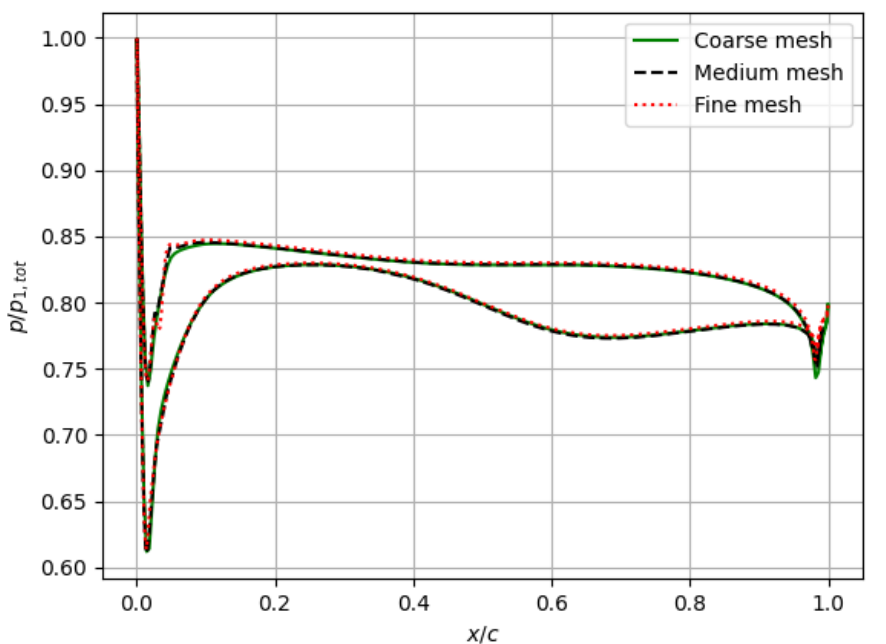
Figure 4. Distribution of the pressure along the middle blade calculated with coarse, medium, and fine mesh ( α = 3°).